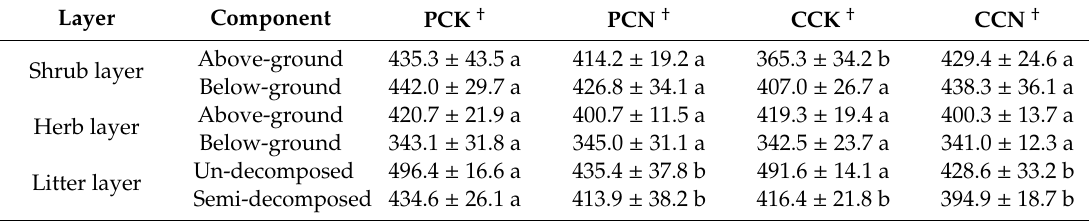
Table 4. C content of the di ff erent components in the underground layer of the four plantation ecosystems (mean ± standard error, n = 4, g · kg − 1